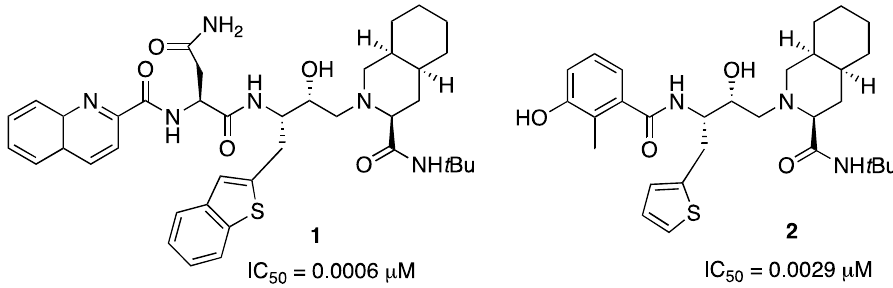
Figure 2. Structures of thienyl and benzothienyl derivatives of saquinavir ( 1 ) and nelfinavir ( 2 ).